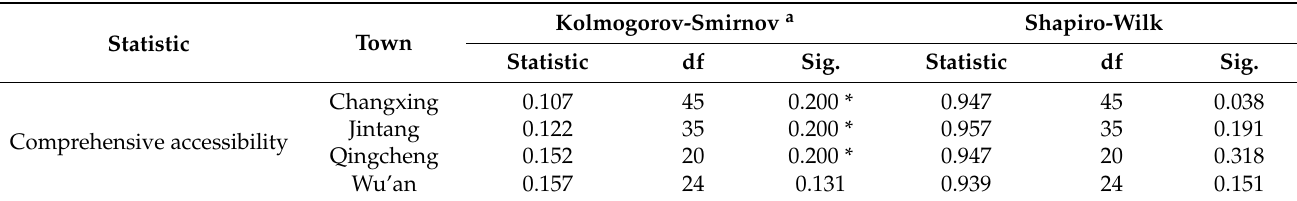
Figure 3. A standard Q–Q plot of the overall urban land accessibility of the sample. Table 5. Normality test table based on the towns where facilities are located.